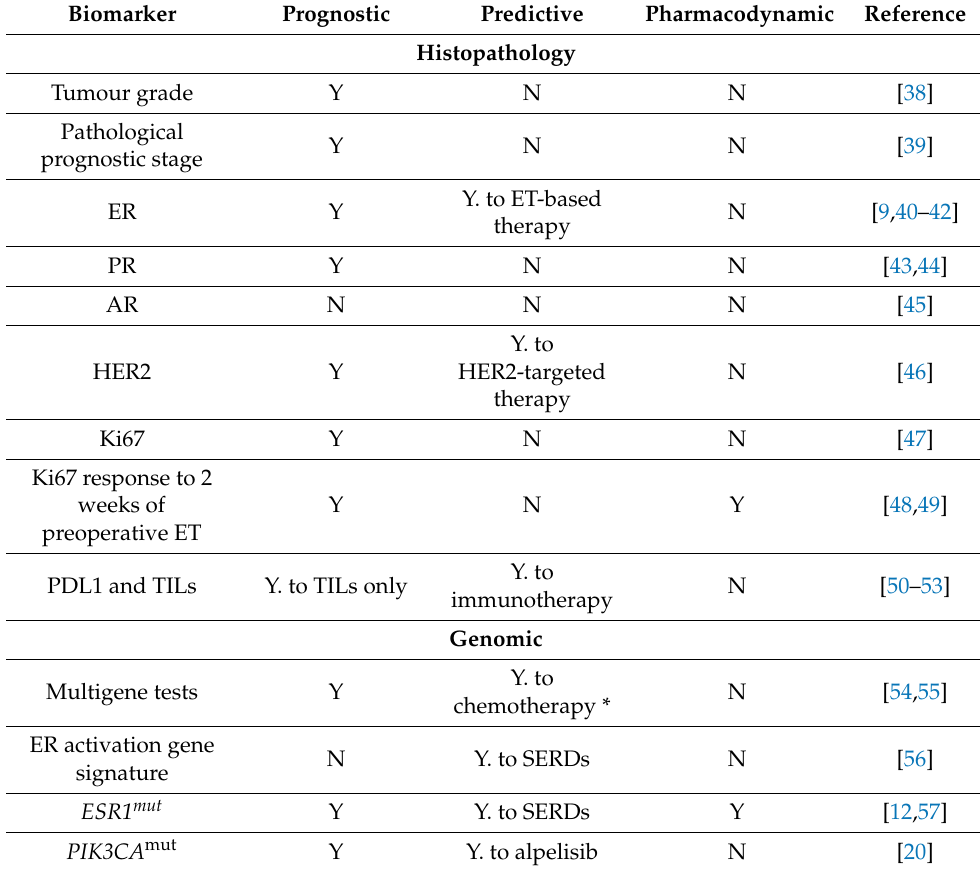
Table 3. Biomarkers in HR+ breast